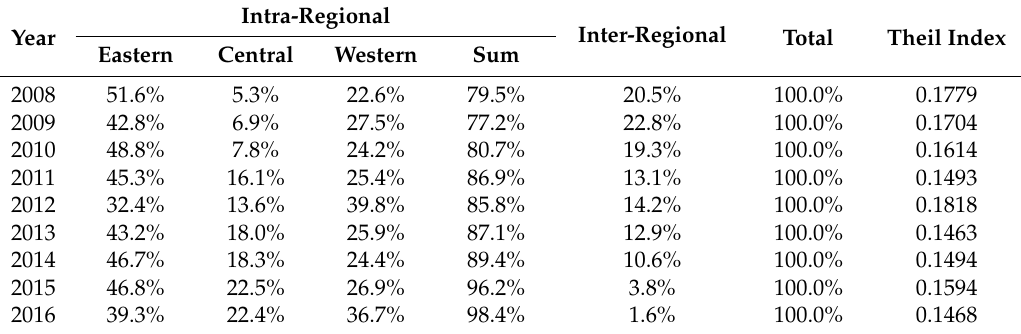
Table 4. Theil index decomposition results